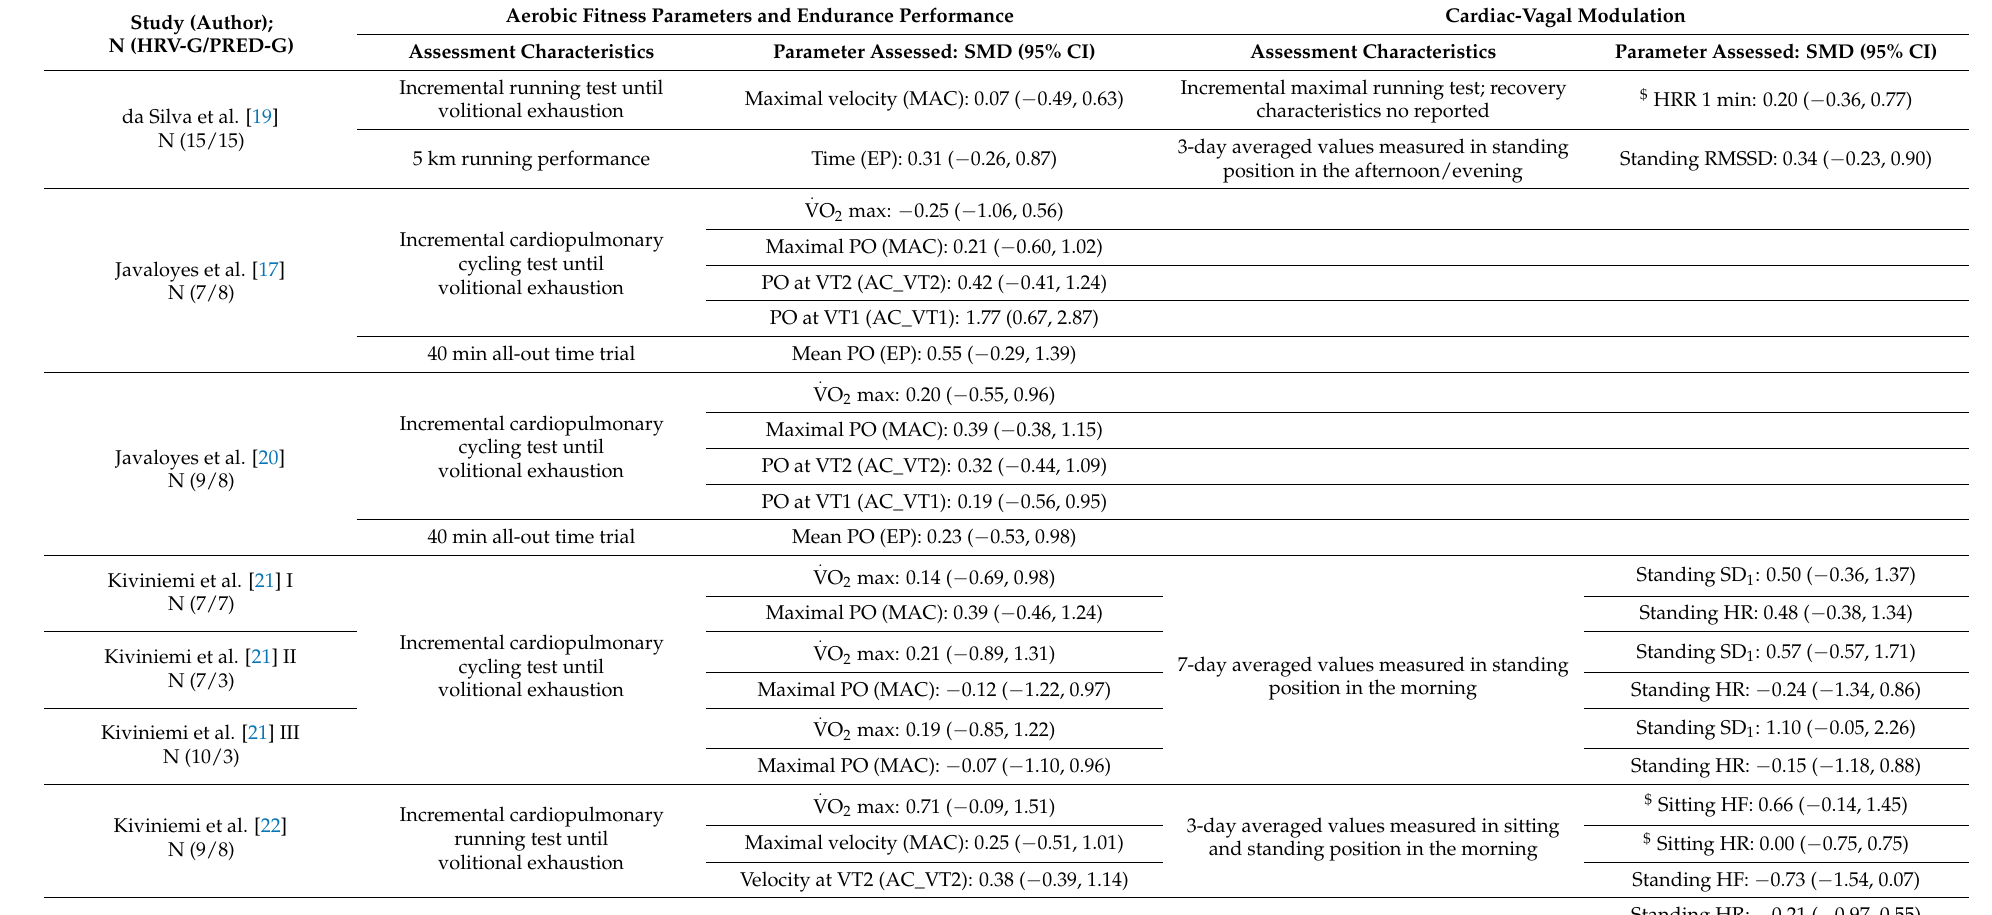
Table 3. Assessment characteristics and outcome